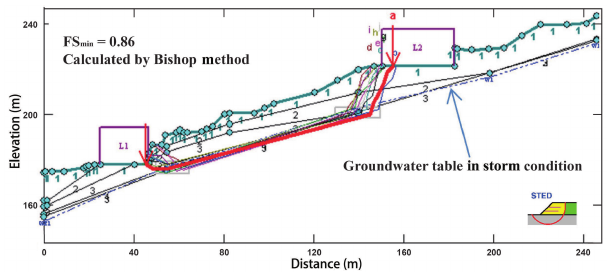
Figure 16. Slope stability (J-J’ cross section) for rainfall condition (FS min =